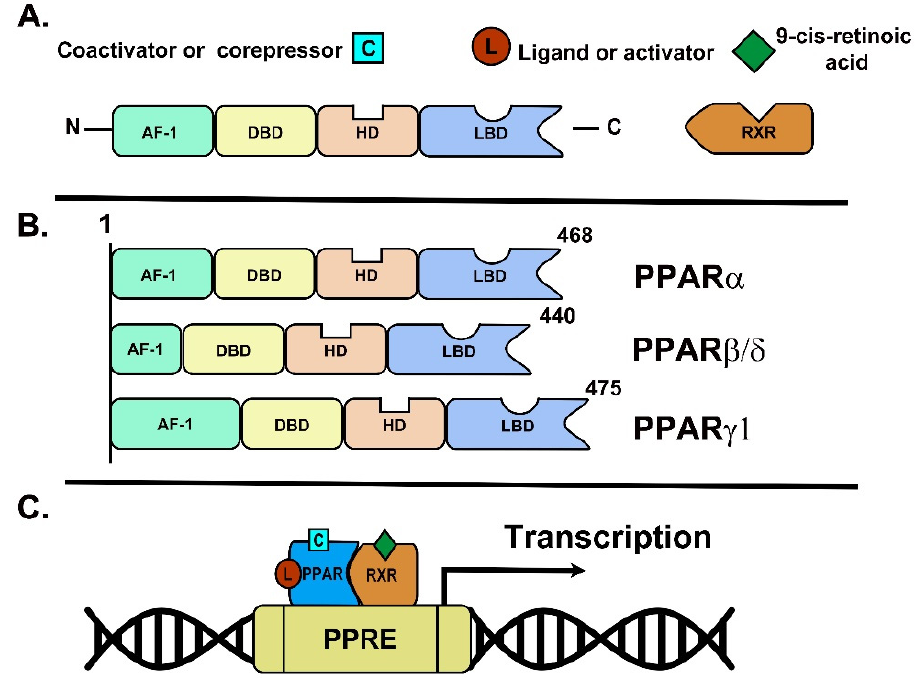
Figure 1. Representation of PPARs’ structure and their molecular function. ( A ) The universal structure of PPARs is represented by AF-1, DBD, HD and LBD domains. The active form of PPARs is heterodimerizing with RXR in conjunction with ligands, co-activators and co-repressors that modulate their function. ( B ) PPARs’ subtypes representations. ( C ) Transcription of PPARs target genes start upon the union of PPAR-RXR and the ligands and co-activators into PPRE sequences.